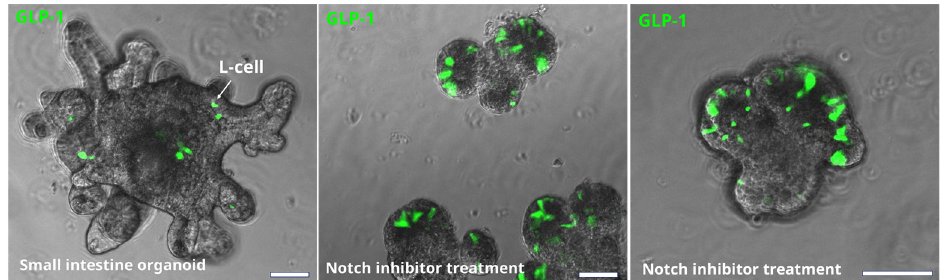
Figure 3. Effect of Notch inhibition on the number of EEC in mouse small intestine organoids. L-cells are identified by immunostaining for GLP-1 (green). Bars are 50 µm. Notch inhibition significantly increases the number of L-cell (and other secretory cells) in intestinal epithelium. However, it also has a negative effect on epithelial growth and crypt formation.